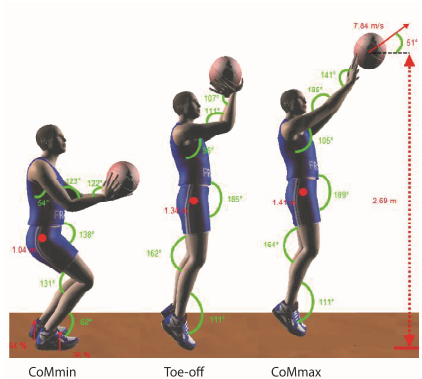
Figure 1. Joint angle orientations ( green lines ) for flexion/extension of all body joints and the position of the centre of mass ( red dot ) at the key time points of the